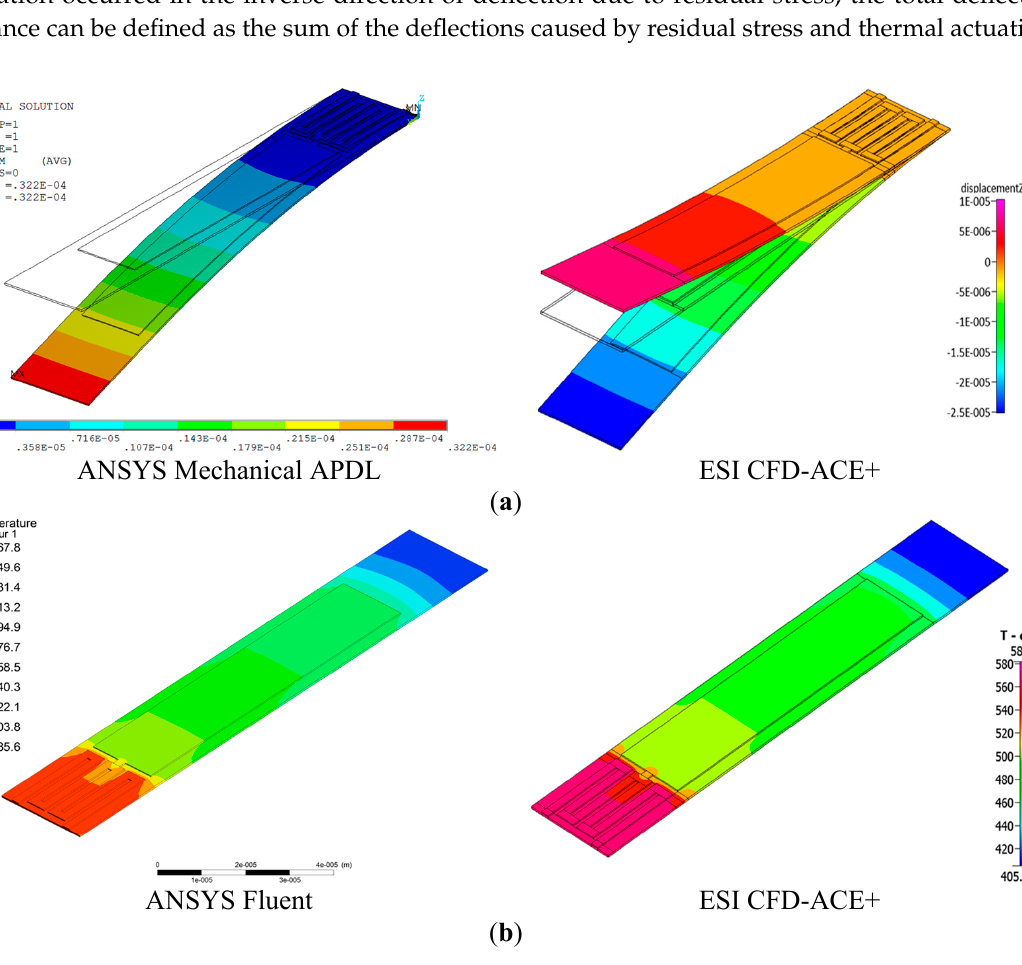
Figure 10. ( a ) Deflection of bimorph microcantilever that occurred by thermal actuation. Total deflection (ANSYS: 32.2 μ m/ESI CFD-ACE+: 35.45 μ m) is determined by the sum of deflections by residual stress and thermal actuation and ( b ) temperature profile of the thermally actuated bimorph microcantilever at the applied current of 20